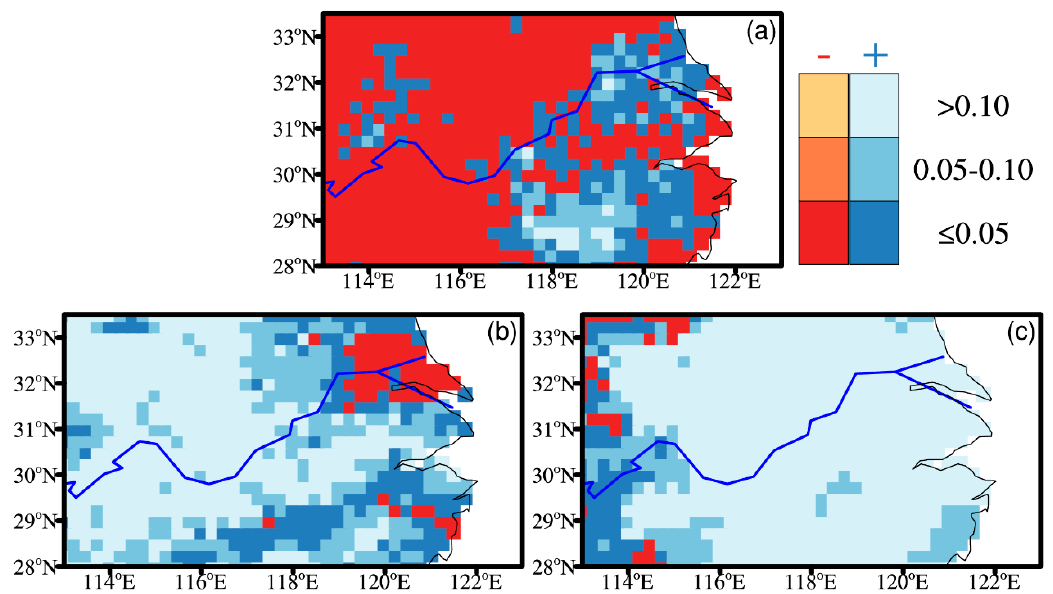
Figure 4. Relationship between summertime precipitation events associated with tropical cyclones (TCs) and El Niño–Southern Oscillation (ENSO), regression coefficients derived from Poisson regression display at different level of significance. ( a ) Normal rainfall events. ( b ) 75th percentile precipitation events. ( c ) 95th percentile precipitation events. The bold blue curve denotes the Yangtze River.